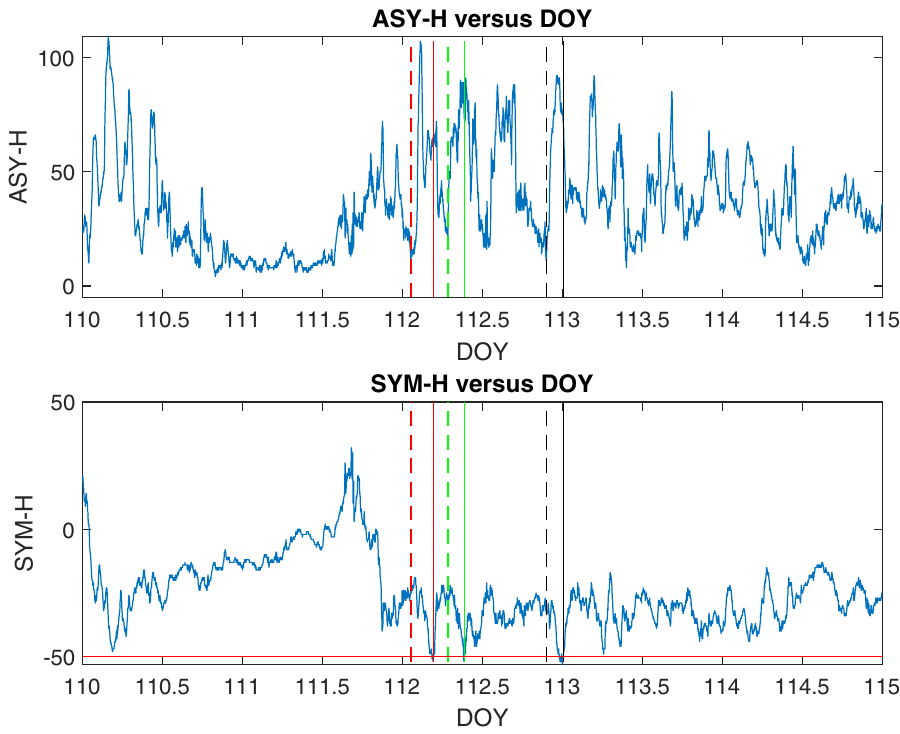
Figure 6. ASY-H and SYM-H behavior during geomagnetic storm of 22 April 2017 (DOY 112). The filter discussed in the section "Applied Filter" were applied to mark disturbed time intervals. Solid lines (black, green and red) show the first occurrence of SYM-H value bellow − 46 nt. Dashed lines (black, green, red) show the start of related sub-storms considering the variation of